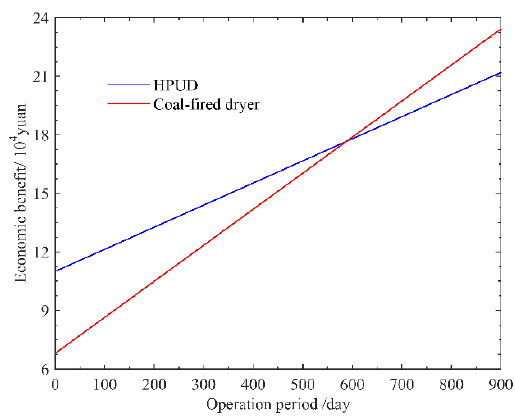
Figure 9. A comparative analysis of the economic benefit.